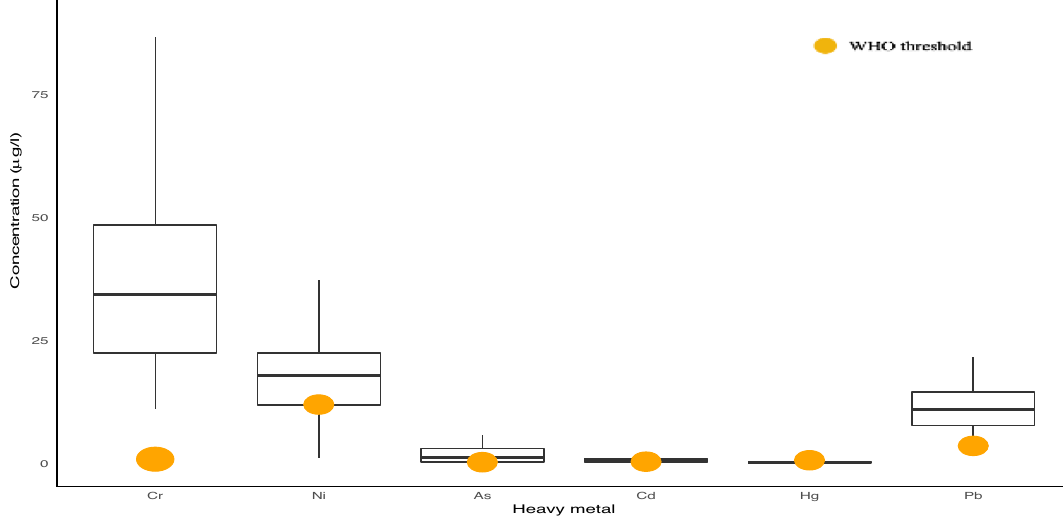
Figure 1. Box-plot of heavy metal concentration levels in breast milk of participants. The bold point in orange shows WHO